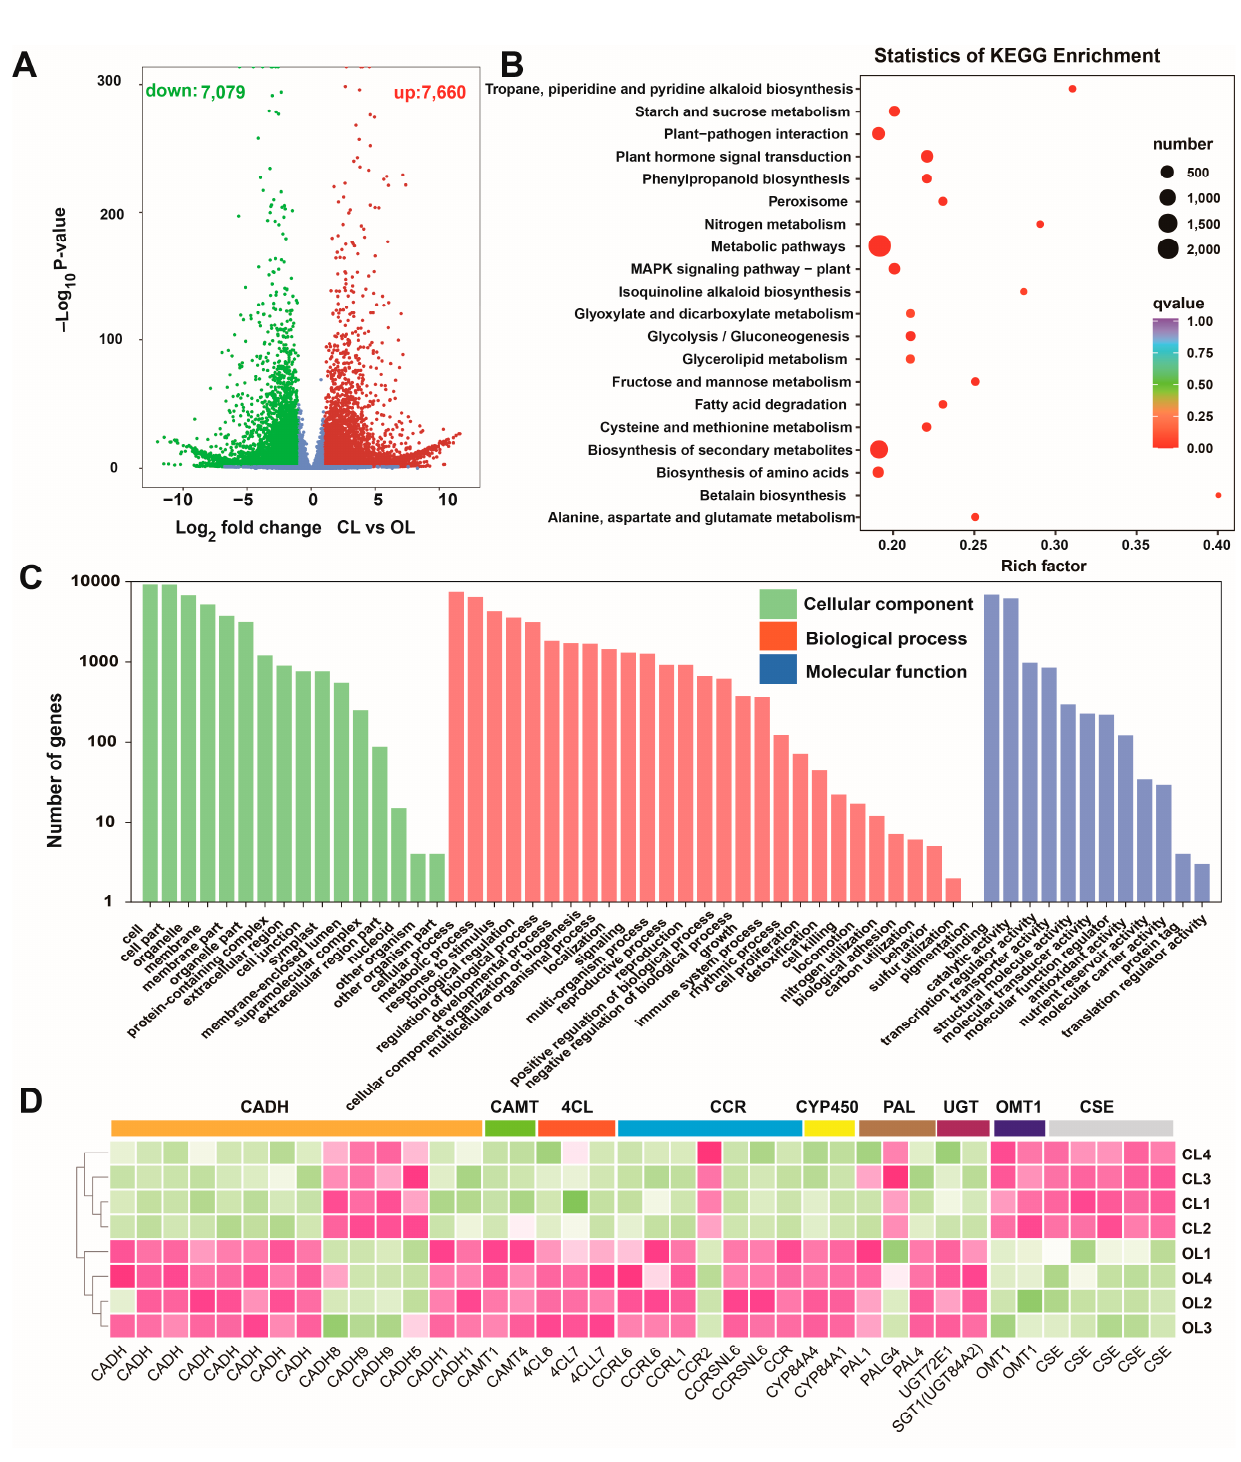
Figure 4. Analysis of the DEGs: ( A ) volcano diagram of the DEGs; ( B ) KEGG pathway enrichment of the DEGs; ( C ) GO enrichment of the DEGs; and ( D ) expression profiles of the DEGs involved in the phenylpropanoid biosynthesis pathway.